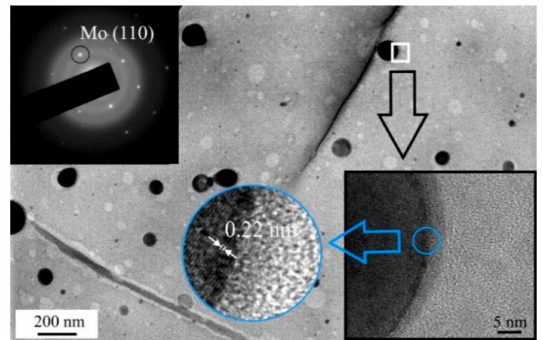
Figure 4. TEM image and selected-area electron di ff raction (SAED) pattern of the thin MoS x~ 2 + δ / Mo thin film obtained by on-axis PLD for 1 min in Ar at a pressure of 8 Pa. The bottom inserts show high resolution TEM images of the